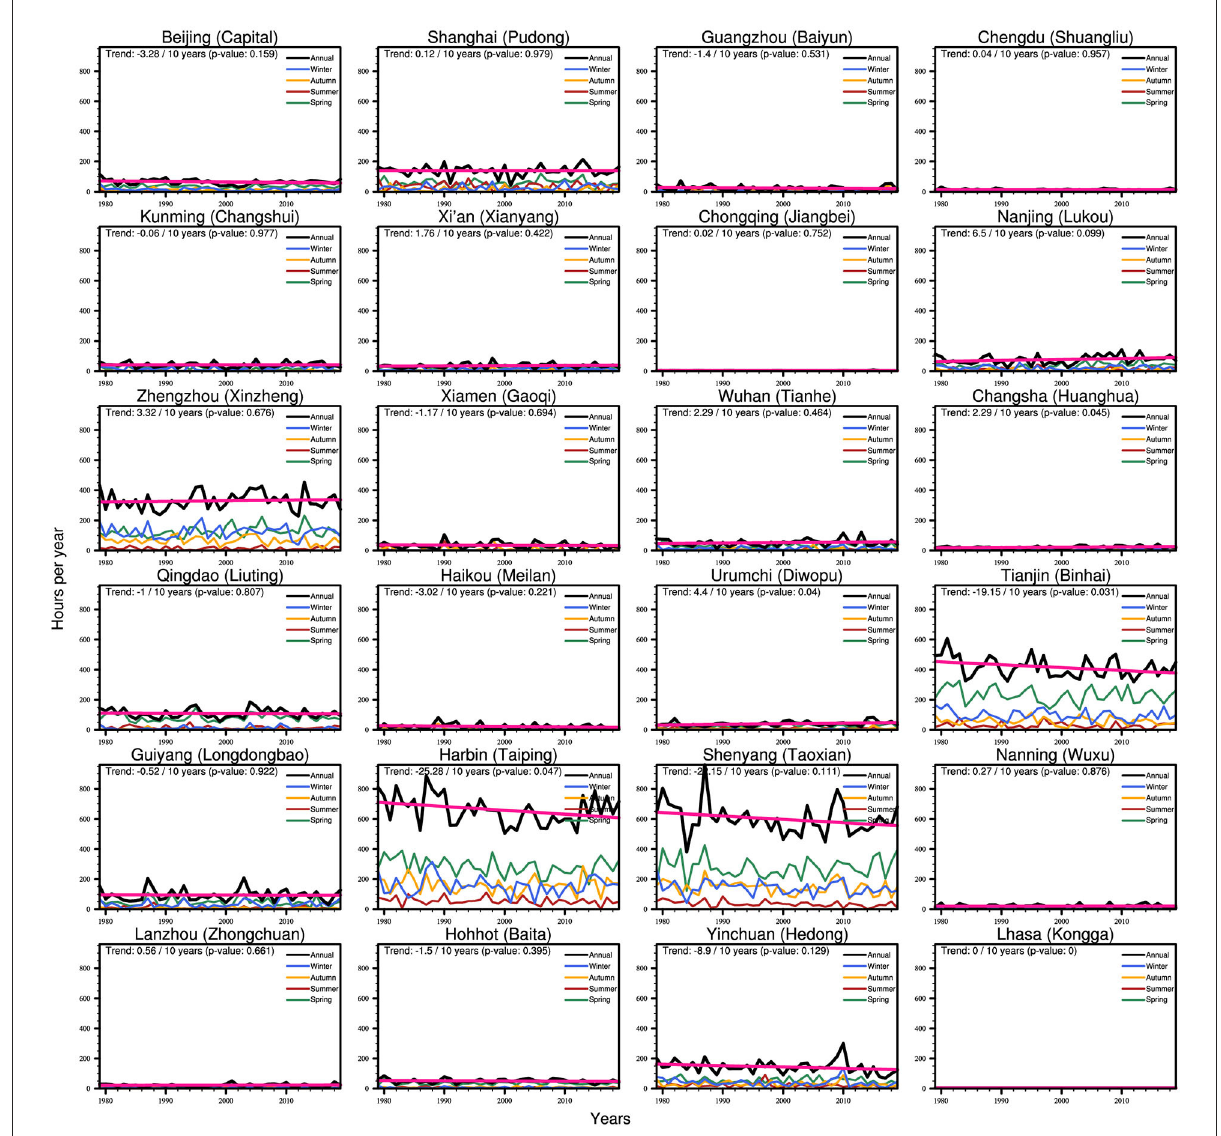
FIGURE9 The inter-annual variability and long-term trend of hours with LLWS over selected airports based on the ERA5 hourly data during